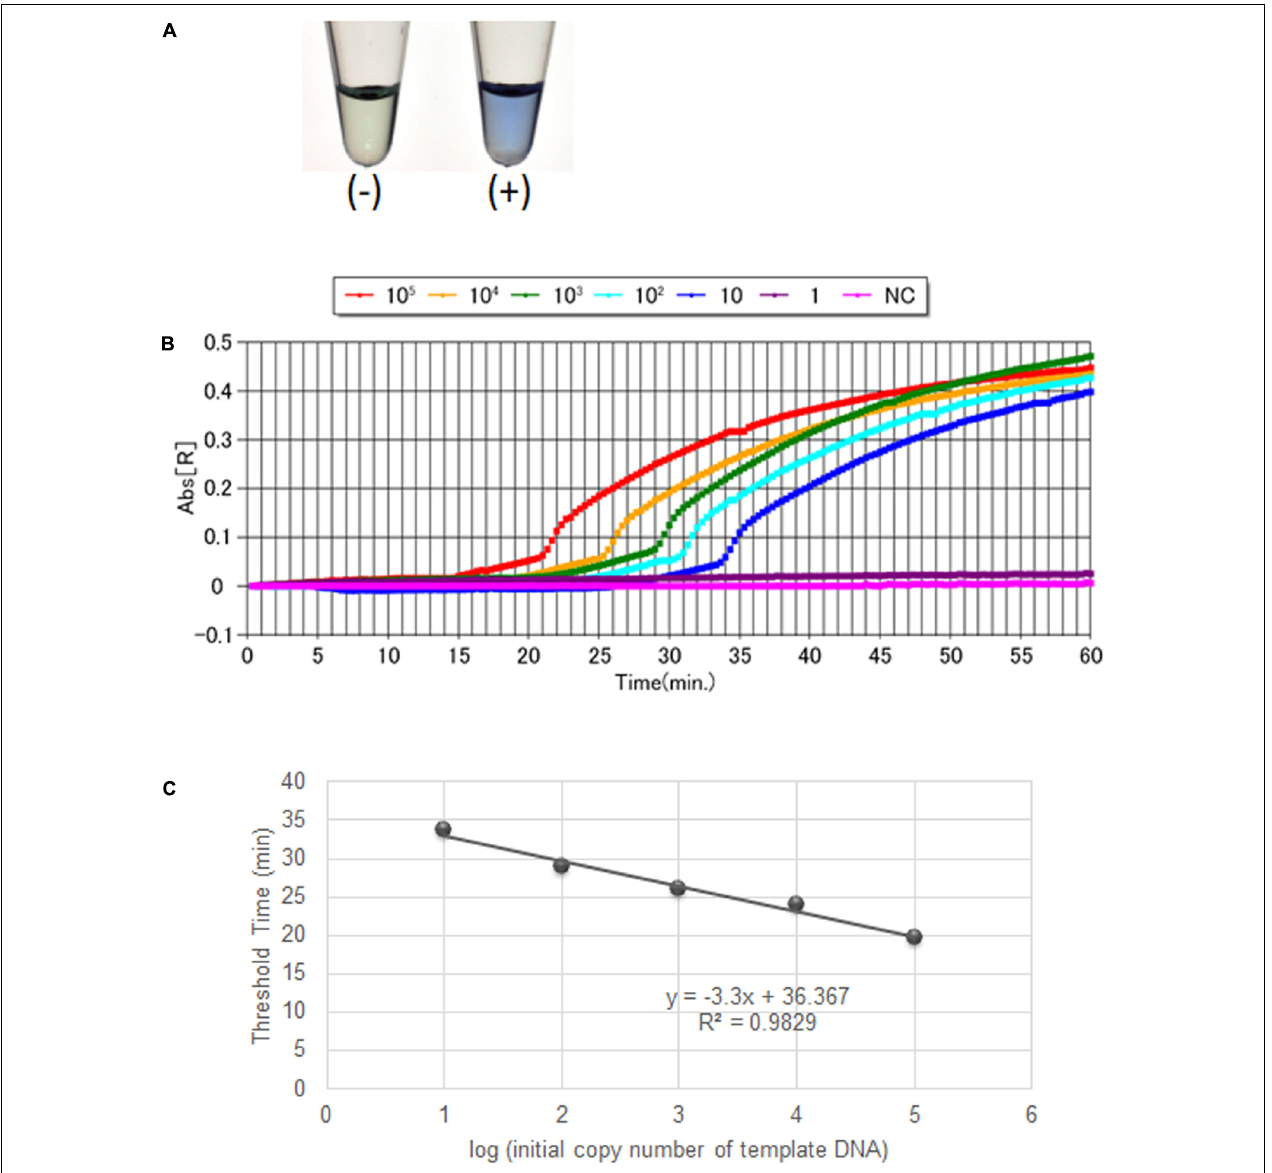
FIGURE 1 | Visual inspection and dye-mediated monitoring of the H. influenzae serotype-specific LAMP assay. (A) , Detection of LAMP reaction using a colorimetric dye (leuco triphenylmethane; D-QUICK). The results were easily recognized by the naked eye, without UV-lamp. (B) , Results of a non-Hib LAMP assay ( H. influenzae type a) using D-QUICK plus MyAbscope R (cid:13) . Numbers of bacteria decrease from left to right in the figure (100,000 to 1 copy number of DNA per reaction). (C) , Linear regression curve of LAMP results ( H. influenzae type a) obtained using D-QUICK plus MyAbscope R (cid:13)